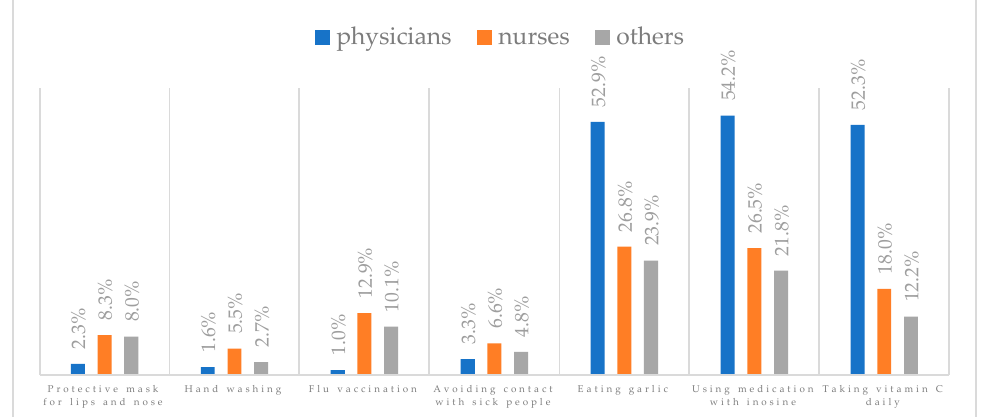
Figure 36. Summary of the indications of each method to prevent influenza virus infection com- pletely effective for each professional group.